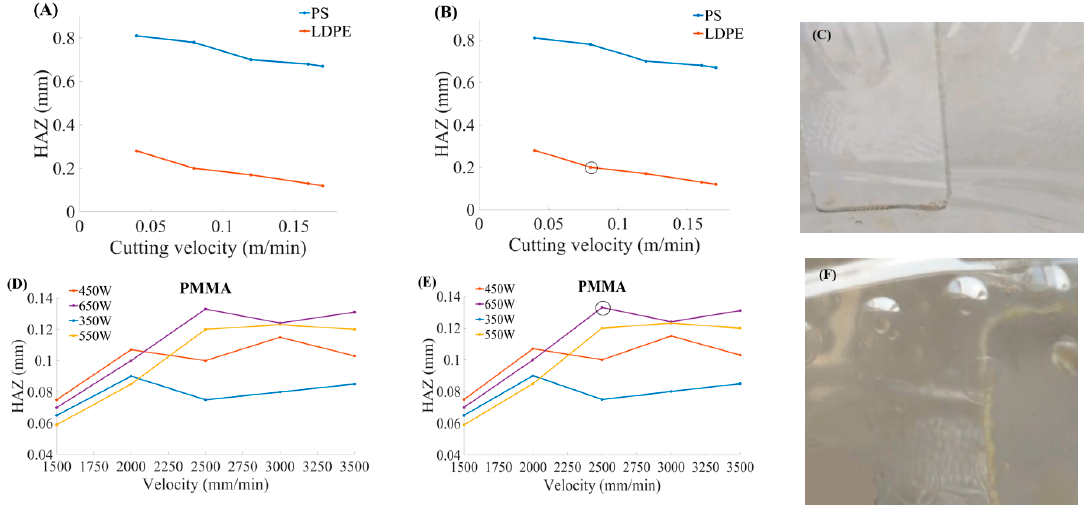
Figure 12. Parametric trends for laser CS, HAZ for PS, LDPE, and PMMA at different power ratings (A): Graphical illustration to show the influence of cutting velocity on HAZ, ( B ) Indication of pointed part of ( A ), ( C ): Pictorial representation of one of the cut parts among PS and LDPE, ( D ): Relationship between cutting velocity and HAZ at different power for PMMA, ( E ): Indication of maximum HAZ from ( D ), and ( F ): Pictorial representation of the cut part with maximum HAZ [52,53].